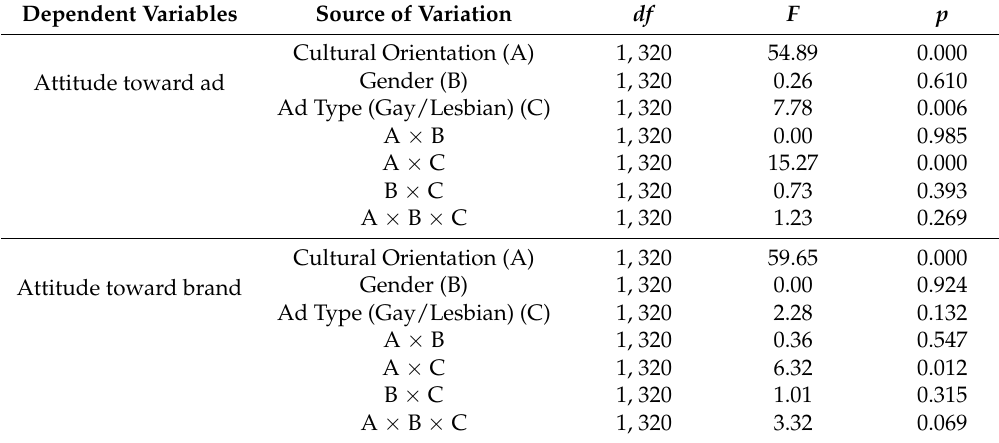
Table 3. Tests of Between-Subject